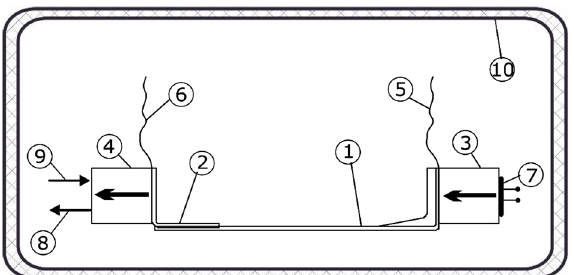
Figure 4. Schematic diagram of the measuring stand. Designations: 1—fastener, 2—mounting element, 3— heater, 4—cooler, 5, 6—K-type thermocouples (0.5 mm in diameter), 7—heating resistor, 8—coolant inlet 9— coolant outlet, 10—insulated casing.